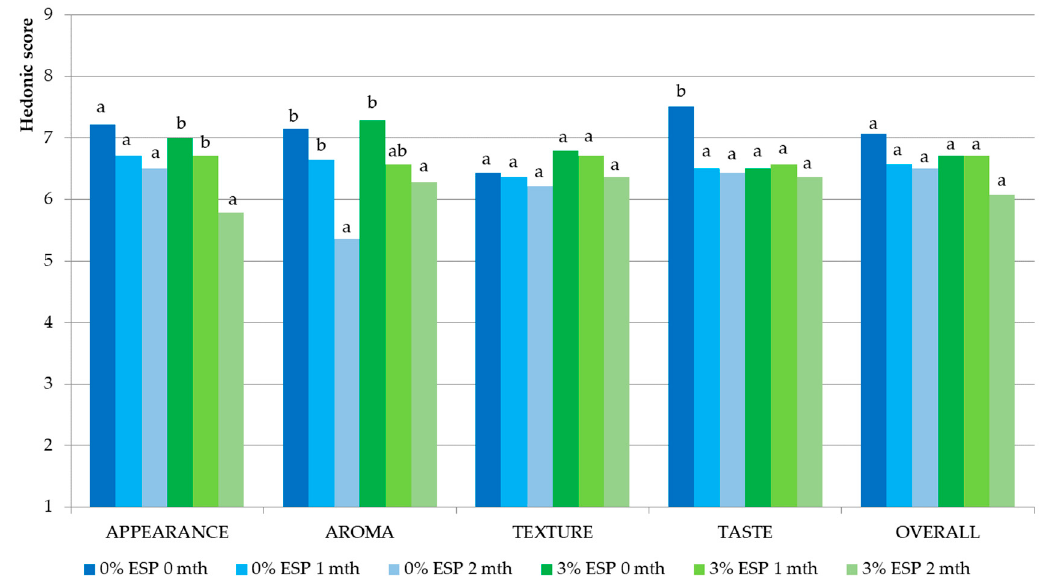
Figure 6. Hedonic evaluation of gingerbread samples during 2 months of storage. ESP: eggshell powder, mth: month of storage. Different lowercase letters in the same concentration of ESP and sensory descriptor indicate significant difference ( p < 0.05).